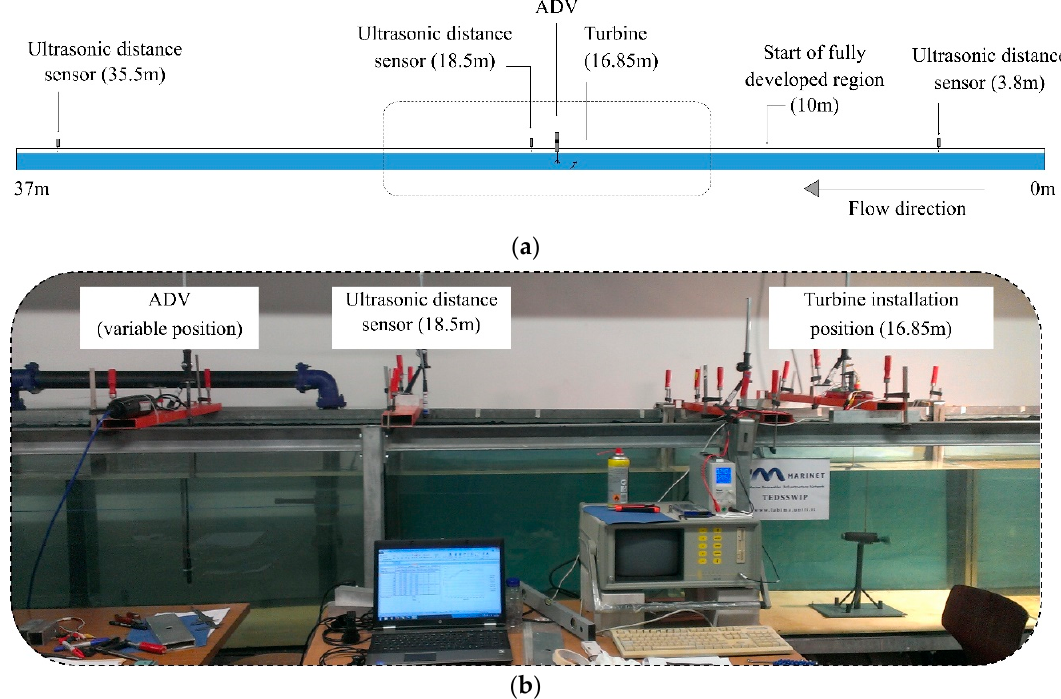
Figure 12. Water channel schematic illustrating measurement locations ( a ); and photograph of central region ( b ).